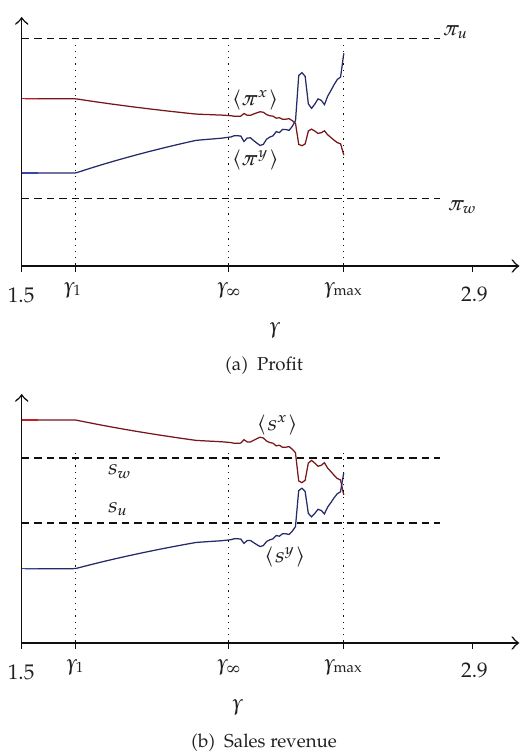
Figure 6: Long-run averages with respect to γ (cid:2) m (cid:6) 1 ,c (cid:6) 1 / 2 (cid:3)